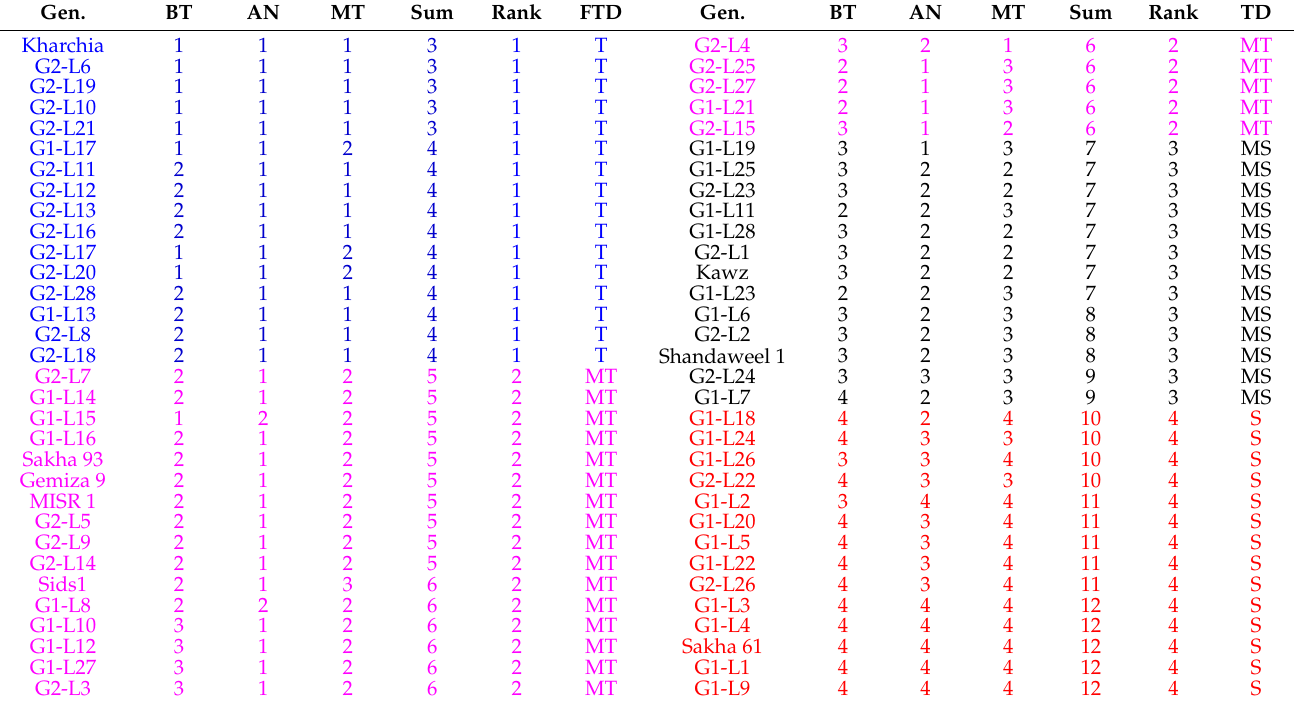
Table 7. Rankings of genotypes (Gen.) for their relative salt tolerance at booting (BT), anthesis (AN), and maturity (MT) growth stages based on plant dry weight, biological yield, grain yield, and different stress tolerance indices in cluster analysis (Ward’s minimum variance